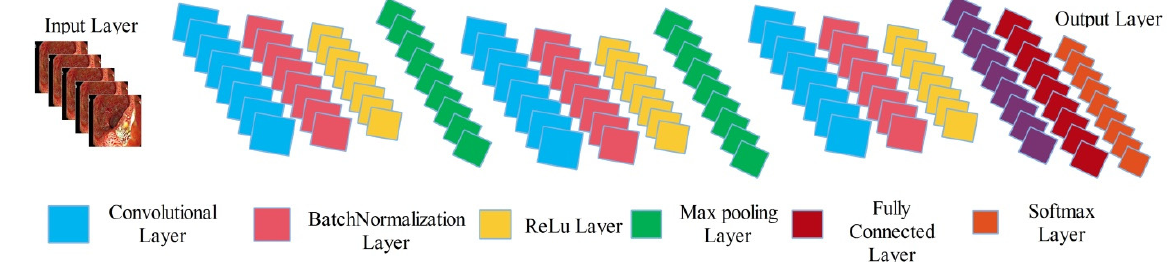
Figure 3. Proposed 14-layered CNN architecture for saliency map construction.